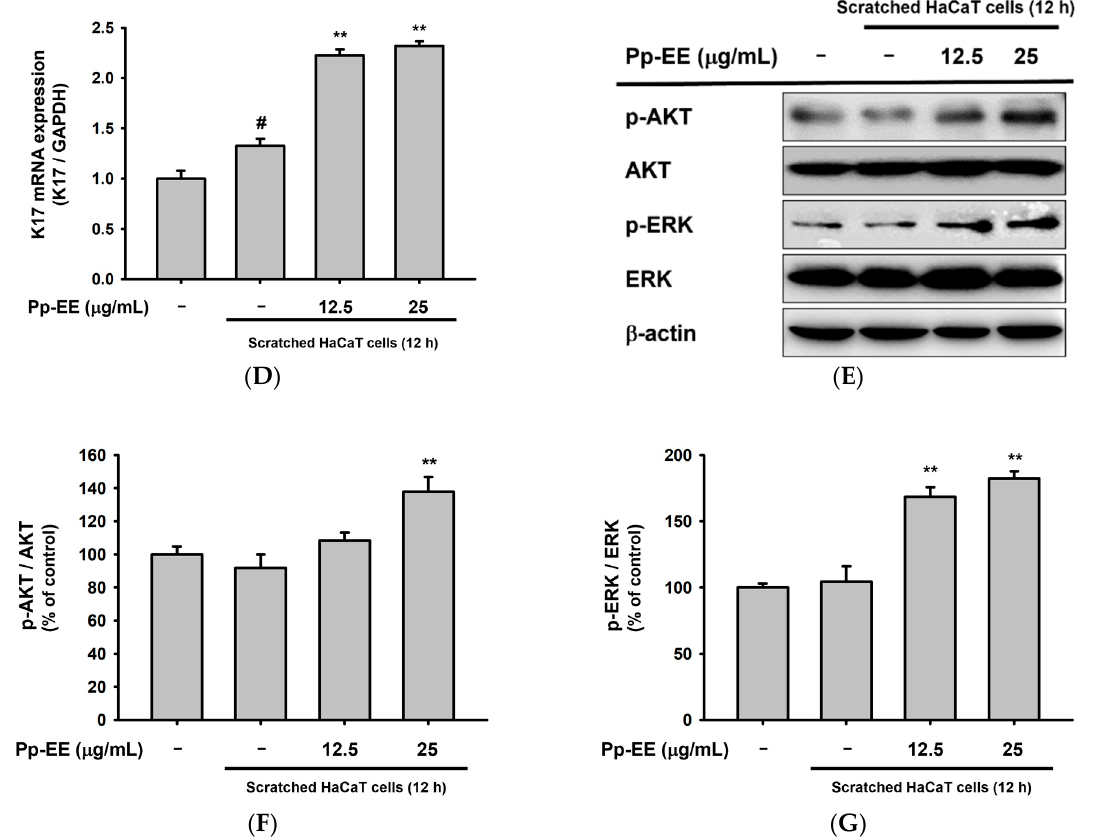
Figure 5. Pp-EE promotes wound-healing processes in keratinocytes. ( A ) The wound-healing activity of Pp-EE in HaCaT cells was evaluated using an in vitro scratch assay. ( B ) The scratch area closed by Pp-EE was determined using ImageJ. ( C ) Confluent HaCaT cells were scratched several times and then treated with Pp-EE (0, 12.5, and 25 μ g/mL) for 12 h. The mRNA expression of K17 was measured by RT-PCR. ( D ) The relative intensities of K17 mRNA were determined using ImageJ. The fold increase represents the ratio of the increased mRNA expression level of scratched groups to the mRNA expression level of the normal group. ( E ) Several scratches were created on confluent HaCaT cells, which were then treated with Pp-EE (0, 12.5, and 25 μ g/mL) for 12 h. The total and phosphorylated forms of AKT and ERK were measured in an immunoblotting analysis. ( F , G ) The relative intensities of the immunoblots were determined using ImageJ. All the results are expressed as the mean ± standard deviation. # p < 0.05 compared with the normal group, and * p < 0.05, ** p < 0.01 compared with the control group.